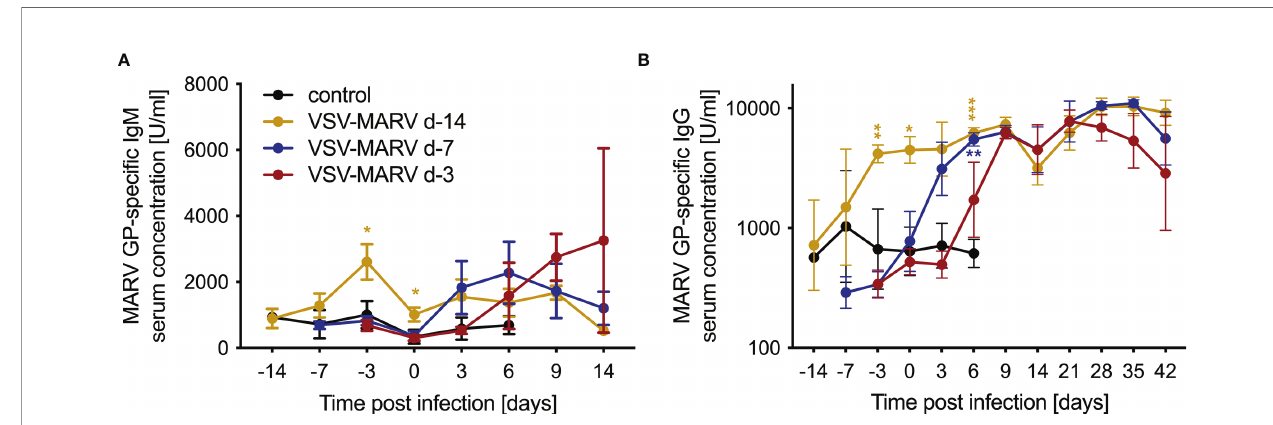
FIGURE 2 | Humoral immune responses after MARV challenge. Concentrations of circulating MARV GP-speci fi c (A) IgM and (B) IgG antibodies in the serum of vaccinated and challenged NHPs. Mean and SD are depicted. Statistical signi fi cance among groups was determined using two-way ANOVA with Tukey ’ s multiple comparisons. Statistical signi fi cance is indicated as ***p<0.001, **p<0.01, and